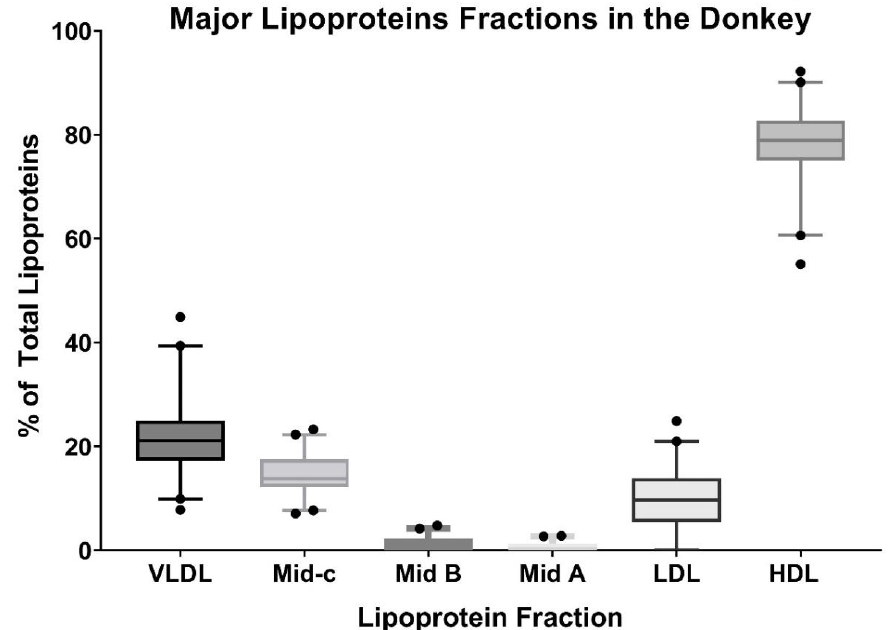
Figure 2. Summative data of the Lipoprint ® fractionation for all donkeys, displaying the median (bar) third and first quartiles (box), and 2.5–97.5% (whiskers) outliers are shown as individual points. The percent of total lipoproteins is generated from the area under the curves from the densitometry